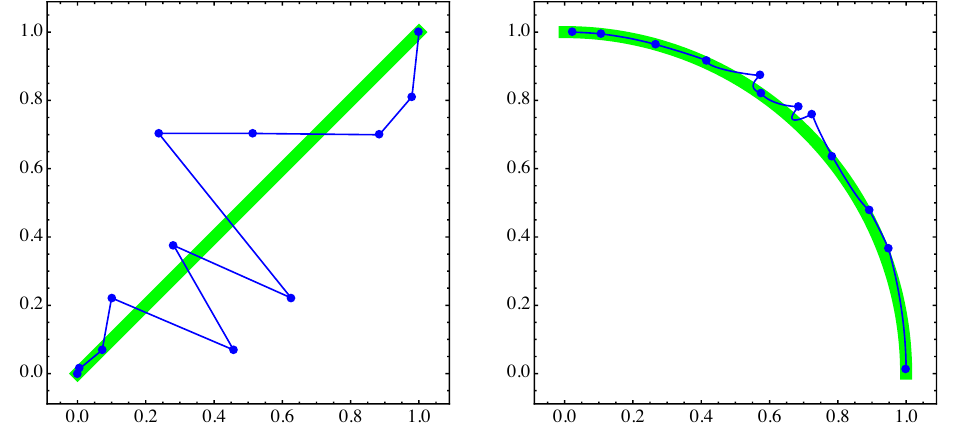
Figure 10. Left: approximations A (blue dots) corresponding to the 500th generation of the NSGA-II algorithm, and B (blue polygon line) of the Pareto set (green thick line) of MOP (12) for n = 2. Right: respective approximations F ( A ) and F ( B ) of the Pareto front for γ = 1/2.